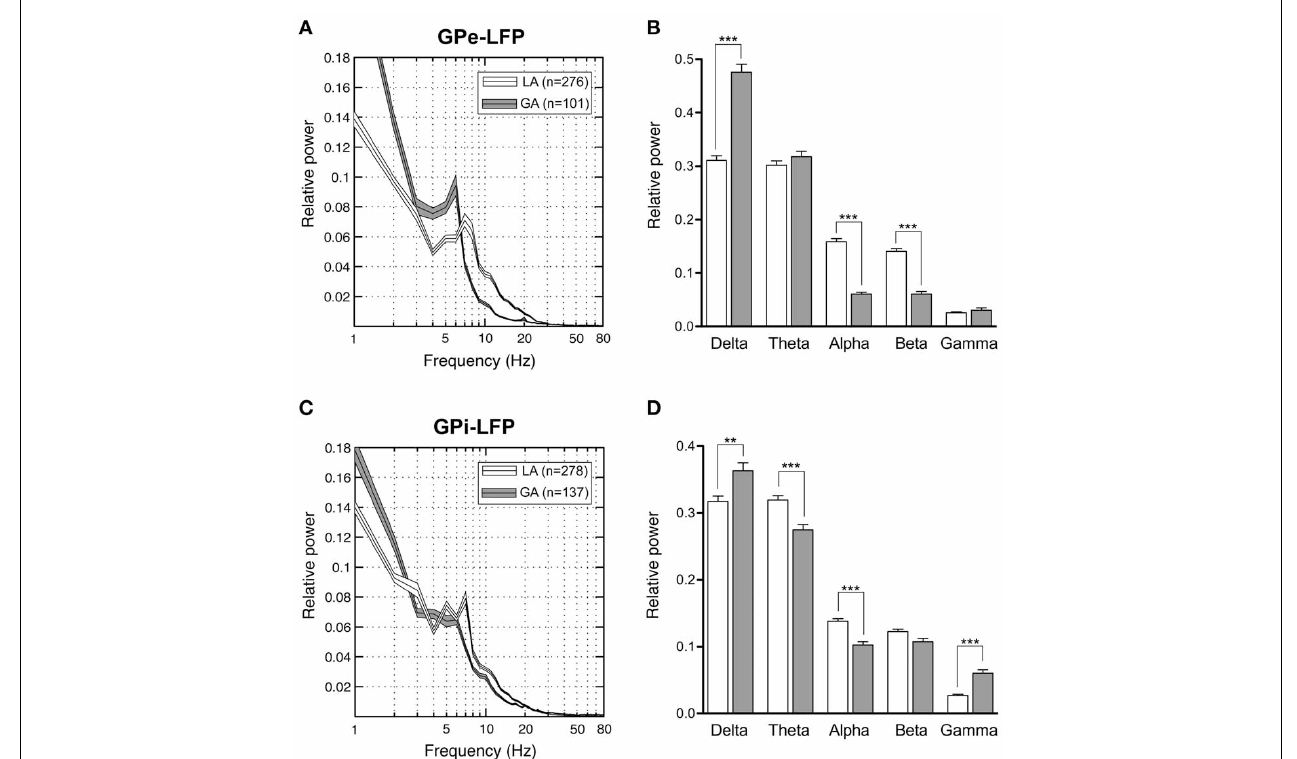
FIGURE 7 | Power spectral analysis of pallidal LFPs in CD patients. (A,C) Grand averages of relative LFP power spectra (mean ± s.e.m.), normalized to total power between 1 and 250Hz, that were recorded under different anaesthetic modalities from GPe (A) and GPi (C) . Depicted frequency range